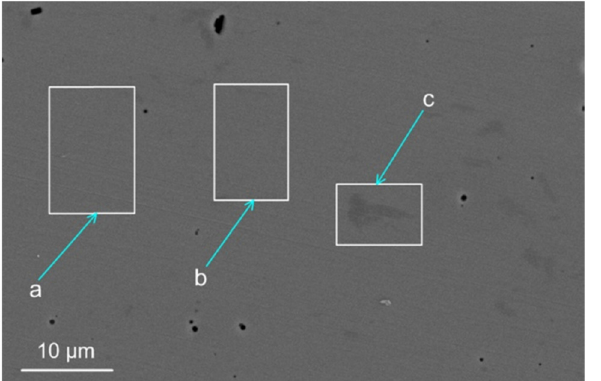
Figure 3: SEM micrograph of MP weld metal with analysed areas a, b and c (× 4,530 ) .